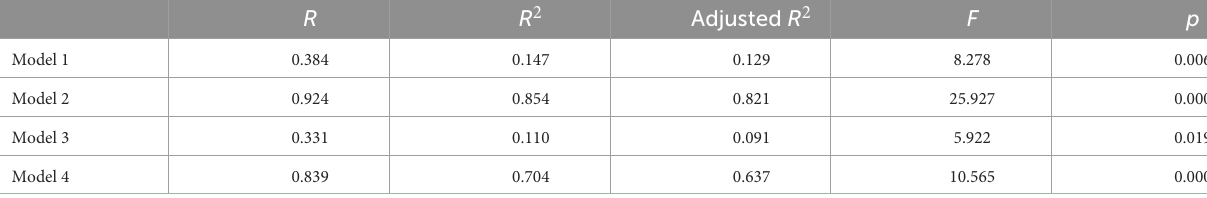
TABLE 4 Fitness of regression models on residential mobility and COVID-19 vaccination rates.